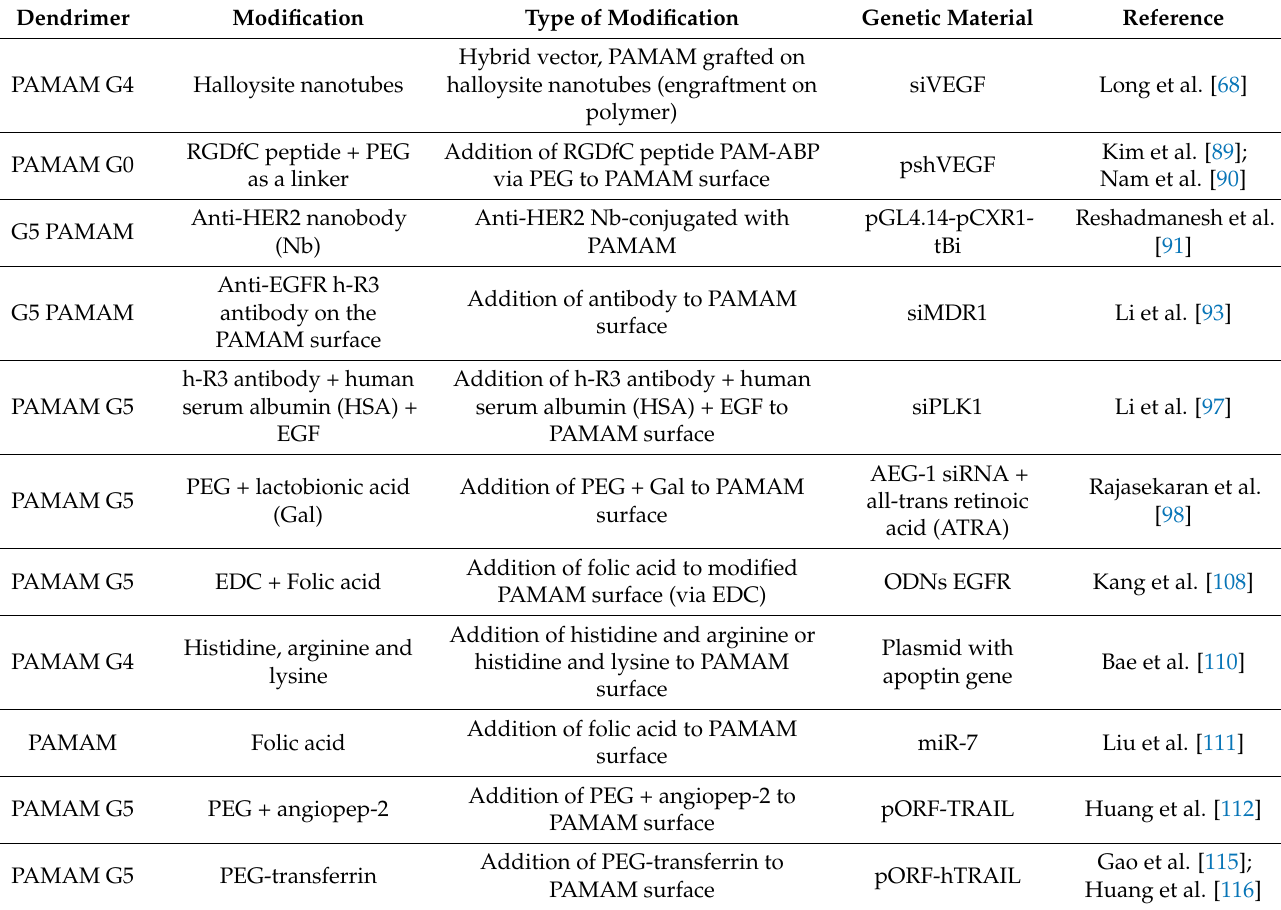
Table 1. Overview of dendrimers with regard to their modifications and the type of delivered genetic material. Dendrimer Modification Type of Modification Genetic Material